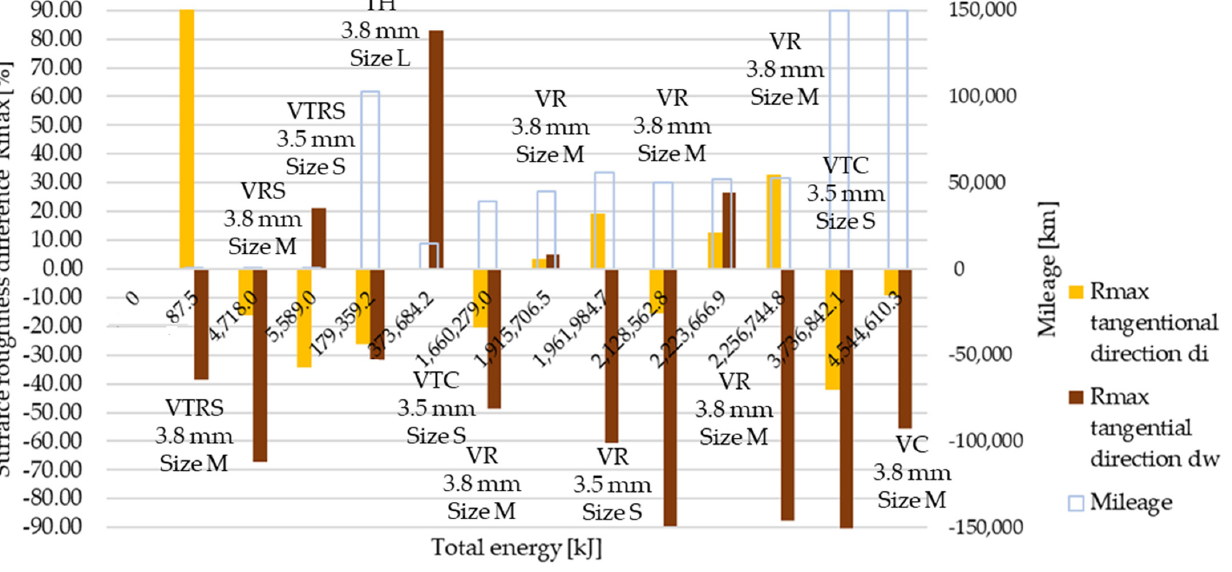
Figure 17. Deviation of Rmax surface roughness values from initial conditions, tangential direction.